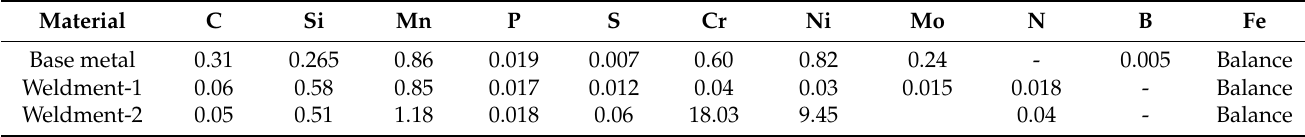
Table 1. Chemical composition (wt. %) of test samples under investigation [3].